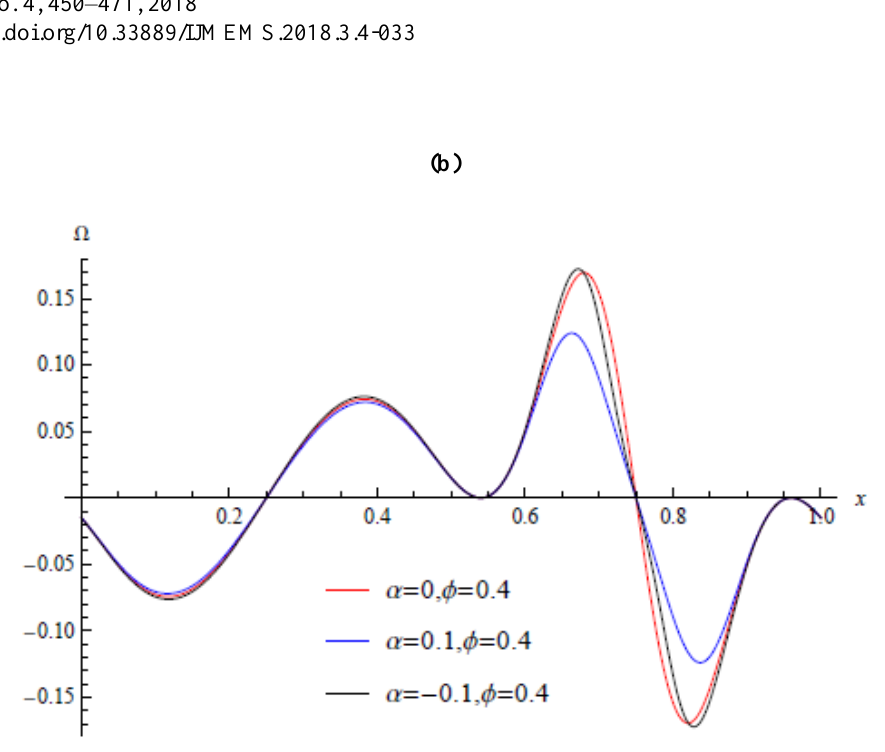
Fig. 13. Heat transfer